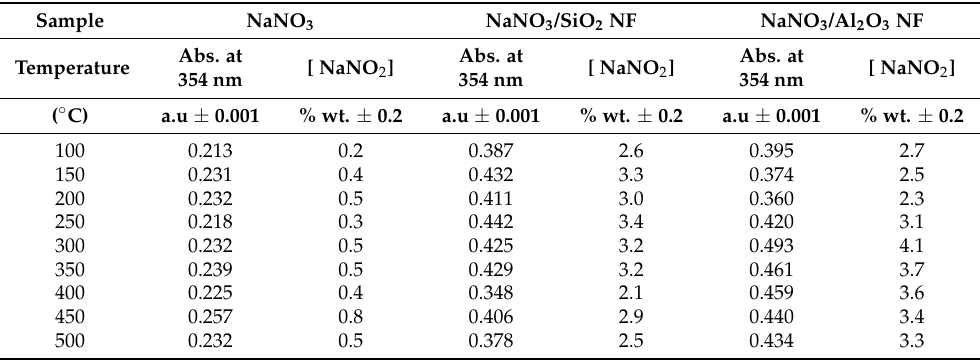
Table 1. Nitrite concentration (% wt.) in pure 0.3M NaNO 3 , 0.3M NaNO 3 /SiO 2 NF (1% wt.) and 0.3M NaNO 3 /Al 2 O 3 NF (1% wt.) derived from the absorbance (arbitrary units) at 354 nm as a function of temperature from 100 ◦ C to 500 ◦